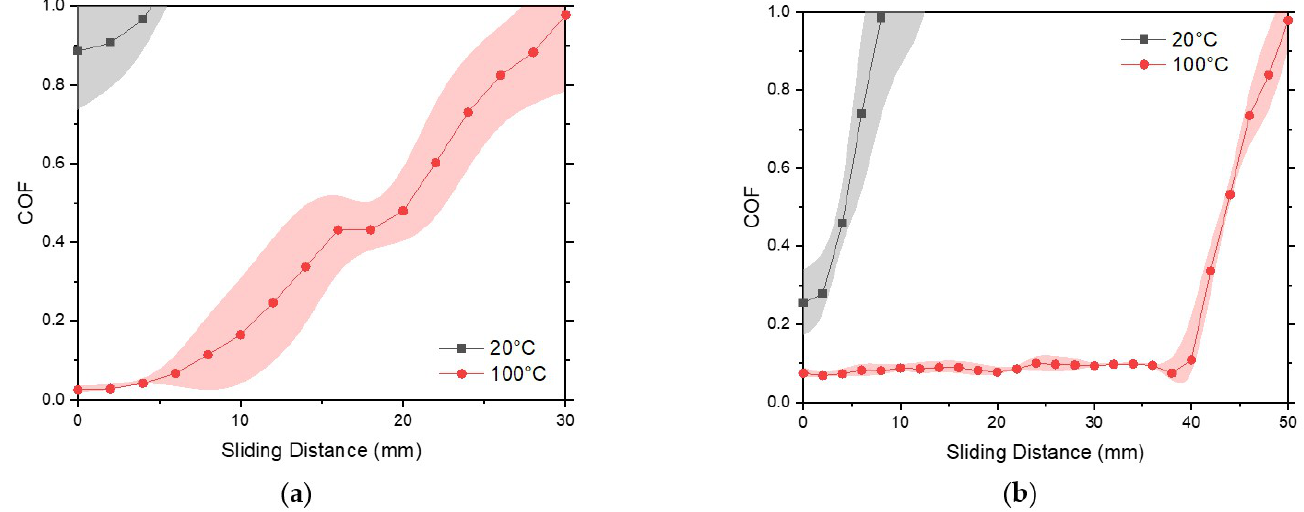
Figure 4. The friction test results of different tool temperatures with a blank temperature of 300 °C for: ( a ) lubricant A; ( b ) lubricant B. The connected scatter lines represent the average coefficient of friction values while the shadows represent the standard deviation.